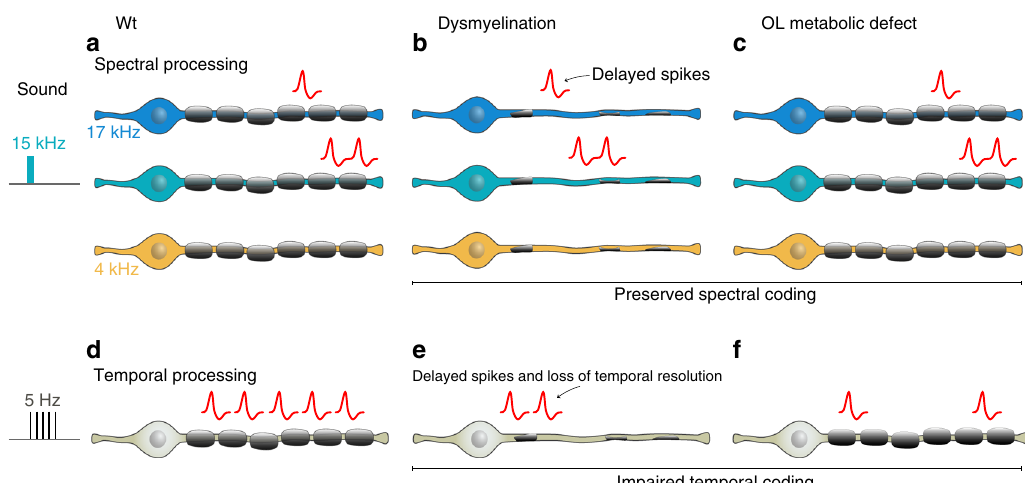
Fig. 7 Role of oligodendrocytes in information processing extends beyond conduction velocity regulation to energy support of axons and axonal excitability regulation. a Schematic illustrating parallel processing of pure tones in a Wt animal. Sound presentation (left, teal, 15 kHz) activates fi bers sensitive to 15 kHz (middle, teal) more strongly than fi bers sensitive to 17 kHz (upper, blue, 17 kHz), and does not activate fi ber sensitive to 4 kHz (lower, yellow, 4 kHz). b With dysmyelination, spectral processing is unaffected, but delayed responses are observed. c Oligodendrocyte metabolic defects affect neither the latency nor strength of responses to simple tones. d Temporal processing of continuous stimuli (i.e., presentation of clicks at 5 Hz) in a Wt animal. e Temporal processing is affected with dysmyelination beyond the increase in conduction velocity (delayed spikes). We observe loss of temporal resolution in both dysmyelination conditions and f with loss of oligodendrocyte metabolic